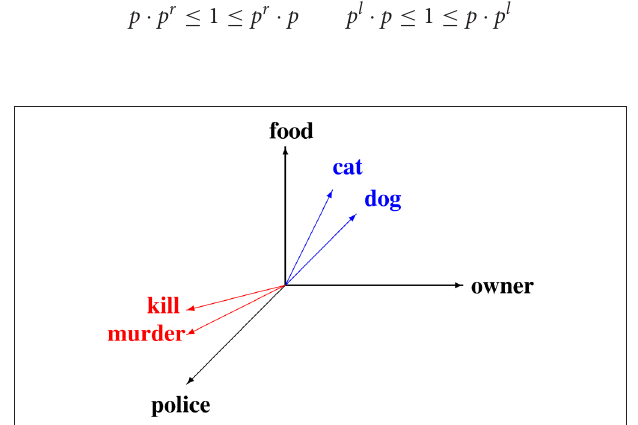
FIGURE 1 | A subspace of a vector space model of meaning, built from real data, cited from Coecke et al. [3].